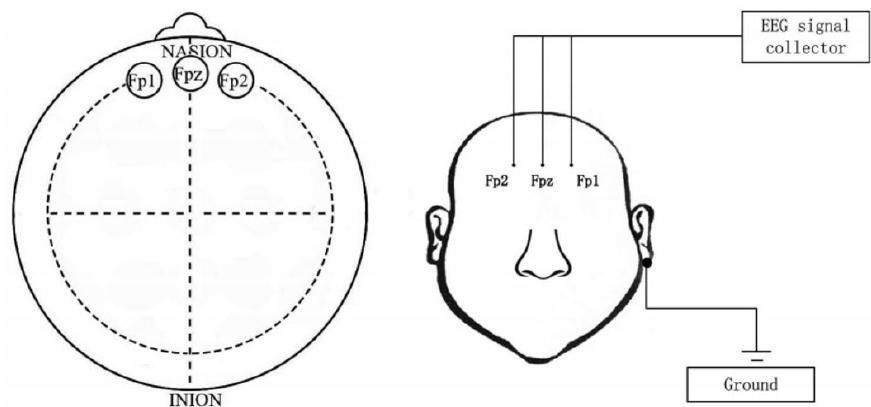
Figure 1. Brain acquisition location and placement of the three-electrode device. Reprinted with permission from Ref. [38]. Copyright 2019, copyright Shen et al.